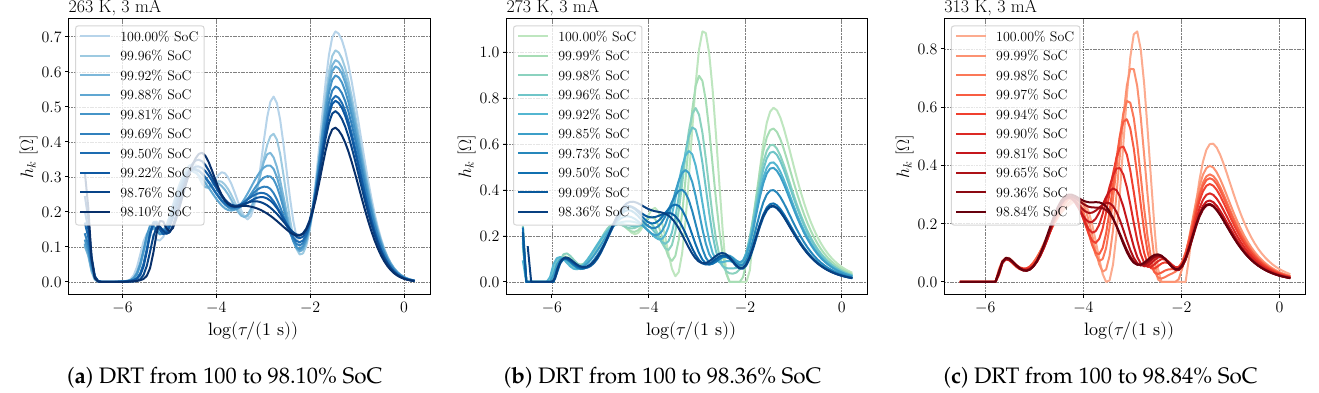
Figure 11. Analysis of operating phase I at different temperatures at 3 mA discharge current. The correlation of the temperature of the DRT at a fixed SoC and a discharge current of 3 mA is shown in Figure 12. The lower the temperatures were, the more significant was the range between log ( τ ) = 2 and log ( τ ) = 0 at an SoC of about 100% (see Figure 12a). − It should be critically mentioned here that in contrast to Figure 11, the full frequency range was used for the measurement, which resulted in longer measurement times and a possible inaccuracy. In the medium State-of-Charge related to Figure 12b, this range was more prominent for higher temperatures and, at the same time, the resistance at log ( τ ) 0.5 ≈ decreased. Finally, for higher temperatures from 294 K, the process at log ( τ ) 0.5 ≈